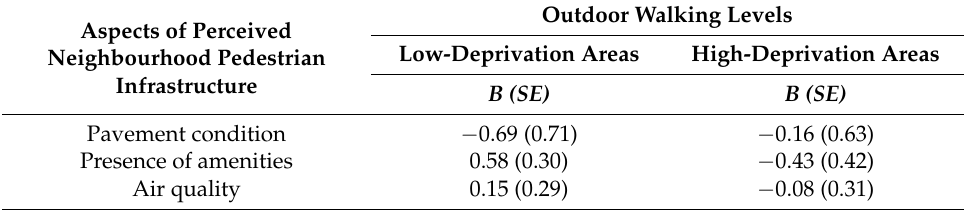
Results of hierarchical regression analyses: relationships between three aspects of perceived neighbourhood pedestrian infrastructure and outdoor walking levels in low- and high-deprivation